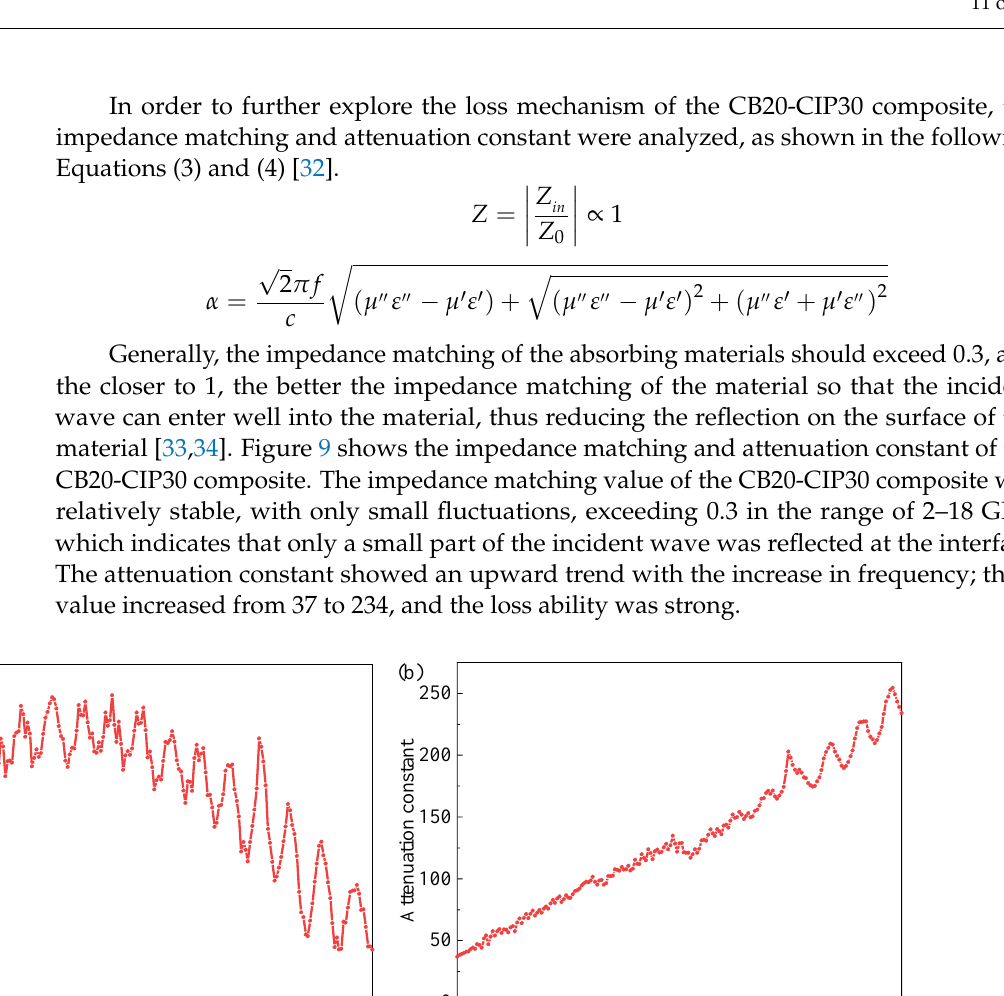
Figure 8. SEM micrographs of the CB20 − CIP30 composite.